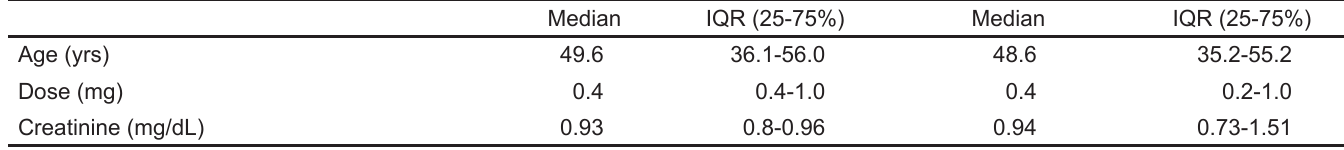
Table 2b. Summary of naloxone use in the emergency